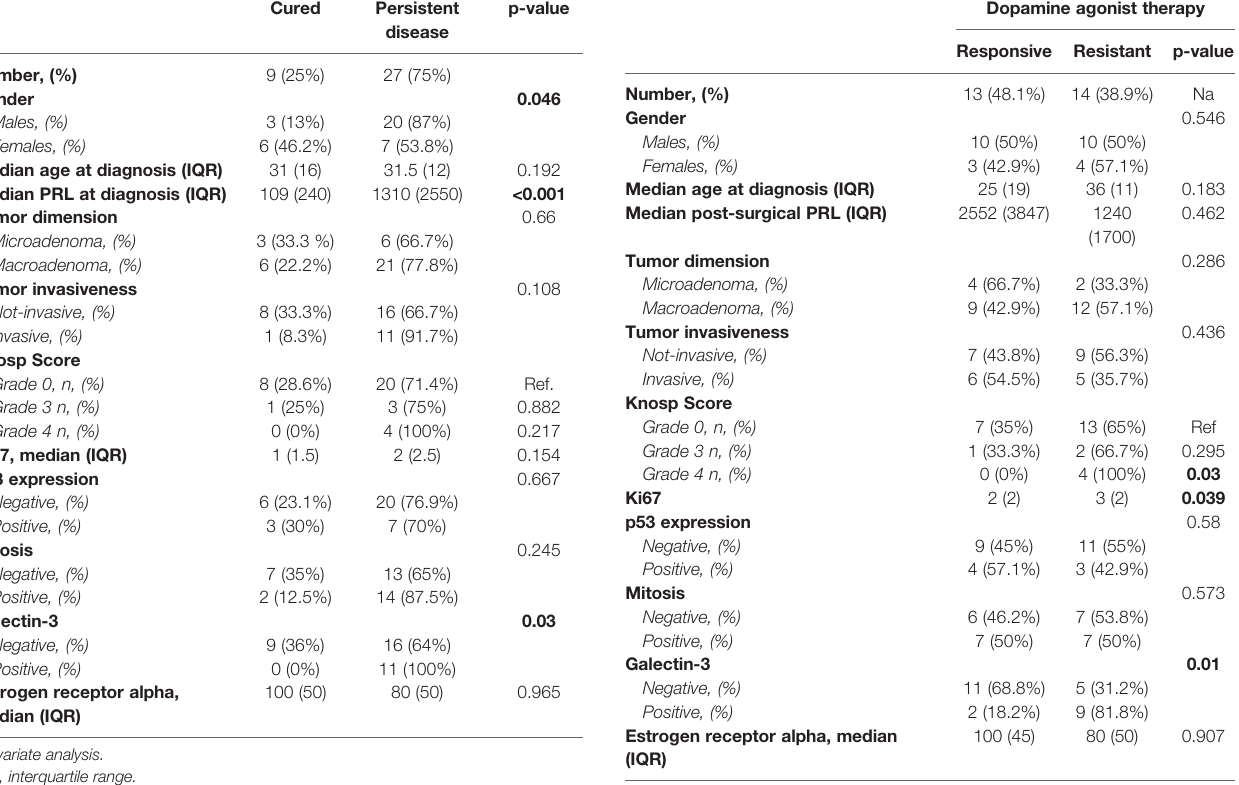
TABLE 3 | Predictors of responsiveness to Cured Persistent disease